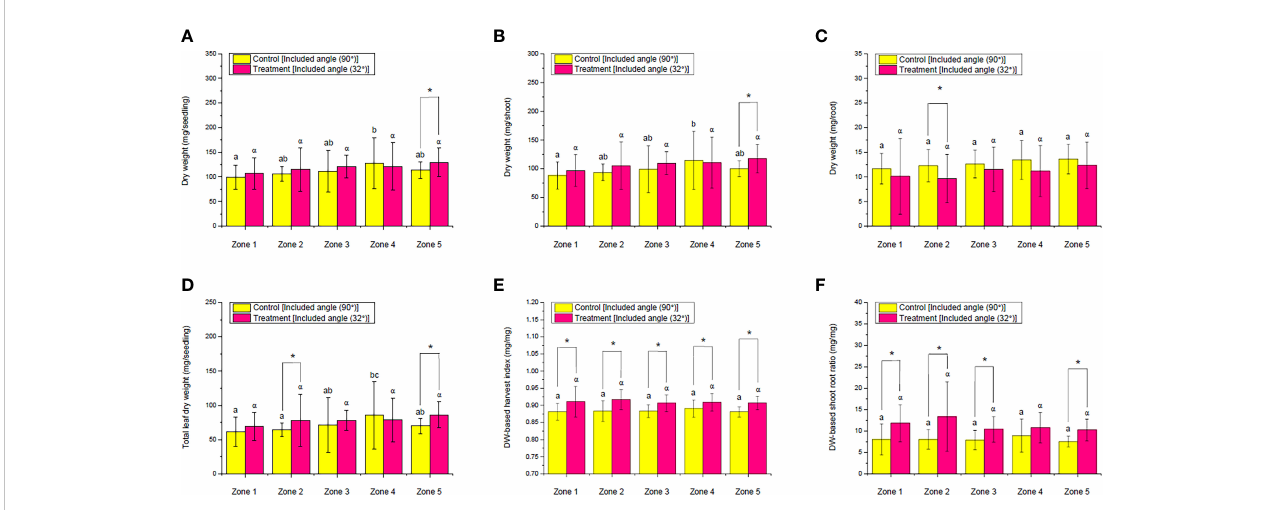
FIGURE 9 Comparison of the dry weight (DW) of (A) seedling, (B) shoot, (C) root, and (D) total leaf as well as (E) DW-based harvest index and (F) DW-based shoot – root ratio of choy sum at seedling stage on day 16 grown in an indoor farm rack with and without the application of an adjustable lampshade-type re fl ector (ALR). The asterisk (*) indicates signi fi cant differences found between the control and treatment (Student ’ s t -test; p < 0.05), the lone Greek alphabet ( a ) indicates that there is no signi fi cant difference found among all the zones with the application of ALR, and the lowercase letters (a, b, and c) indicate signi fi cant differences among all the zones without the application of ALR ( N zone1 = 45, N zone2 = 38, N zone3 = 32, N zone4 = 26, N zone5 = 19, one- way ANOVA; Tukey multiple-comparison; p < 0.05).